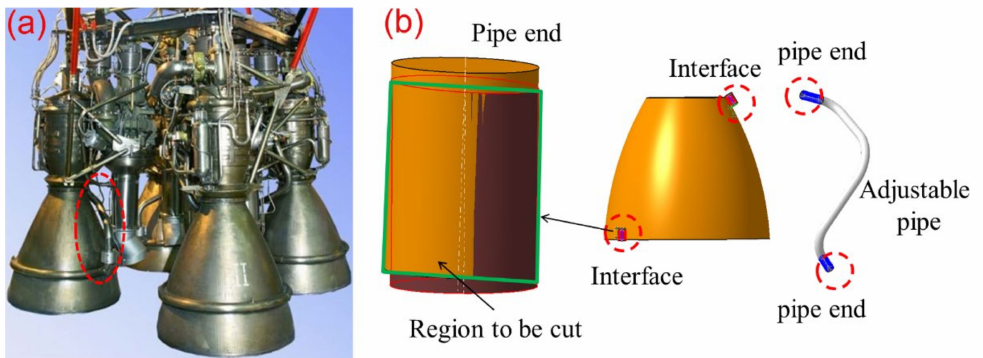
Figure 1. Illustration of pipe assemblies: ( a ) a real rocket engine; ( b ) CAD model for pipe and main body (corresponding to physical body shown in dashed circle in Figure